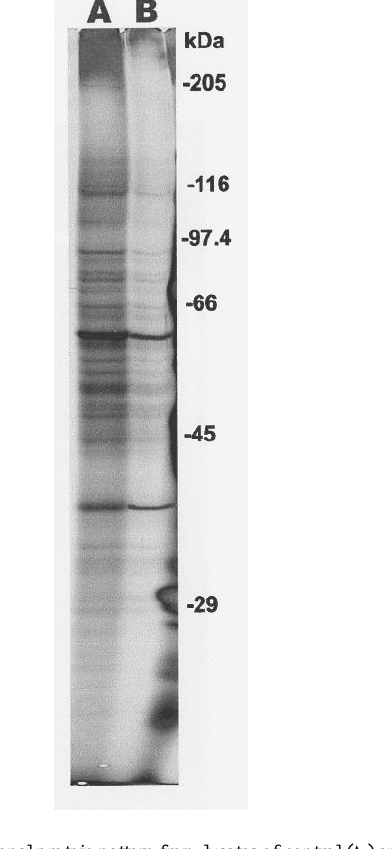
FIGURE 5. Electrophoretic analysis of monodimensional protein pattern from lysates of control (A) and PTHrP-treated (B) MDA-MB231 cell preparations. 10% SDS-PAGE, silver